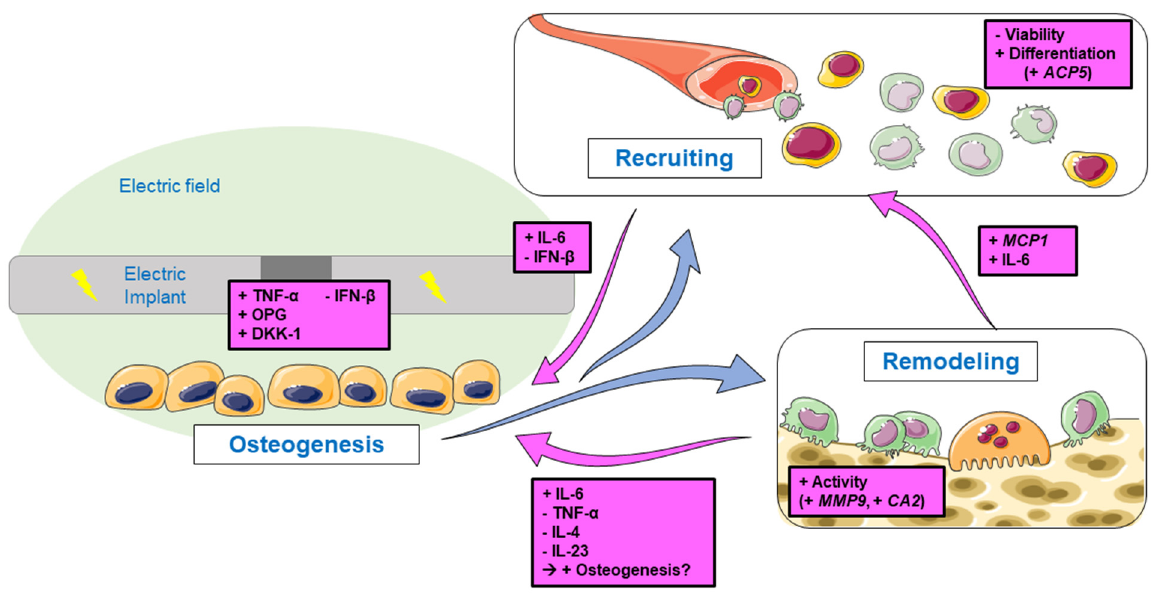
Figure 7. Schematic overview of the aims and results of this study. Stimulated osteoblasts produce signaling molecules that influence osteoclastogenesis through recruiting and remodeling processes. The observed changes in gene expression and protein release of the progenitor cells and osteoclasts- like cells are shown in pink. Single pictures were used from Servier Medical Art (http://smart.servier.com/, accessed on 14 June 2022).